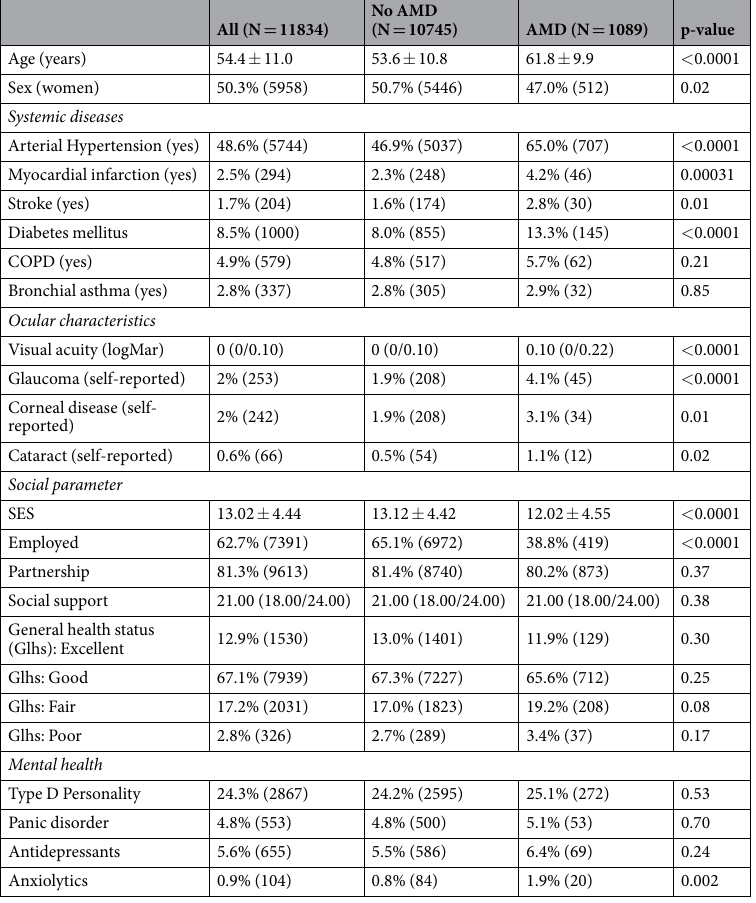
Table 1. Characteristics of participants with (N = 1,089) and without (N = 10,745) AMD, with available psychiatric measurements at baseline in the Gutenberg Health Study 2007–2012. Abbreviations: COPD (chronic obstructive pulmonary disease), Glhs (general health status), SES (socioeconomic status).